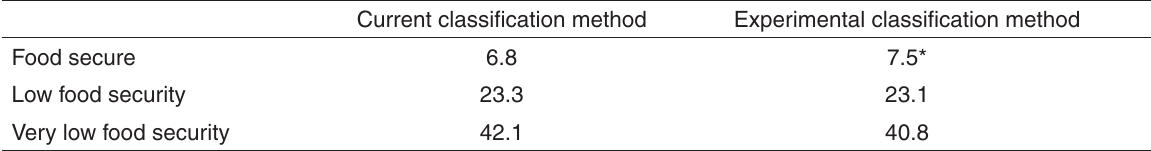
Table 4 Percent of households with children and income less than 185 percent of the Federal poverty line that used a food pantry, by food security status, 2008-15